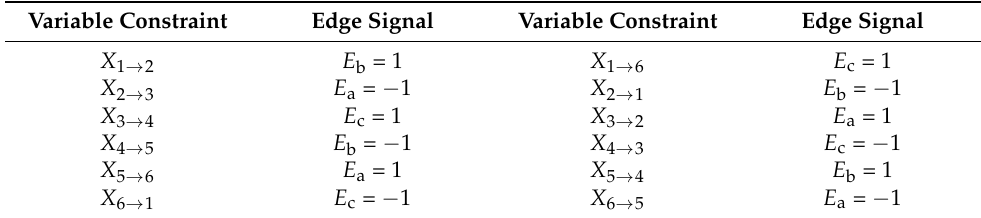
Table 4. Variable Constraints of the